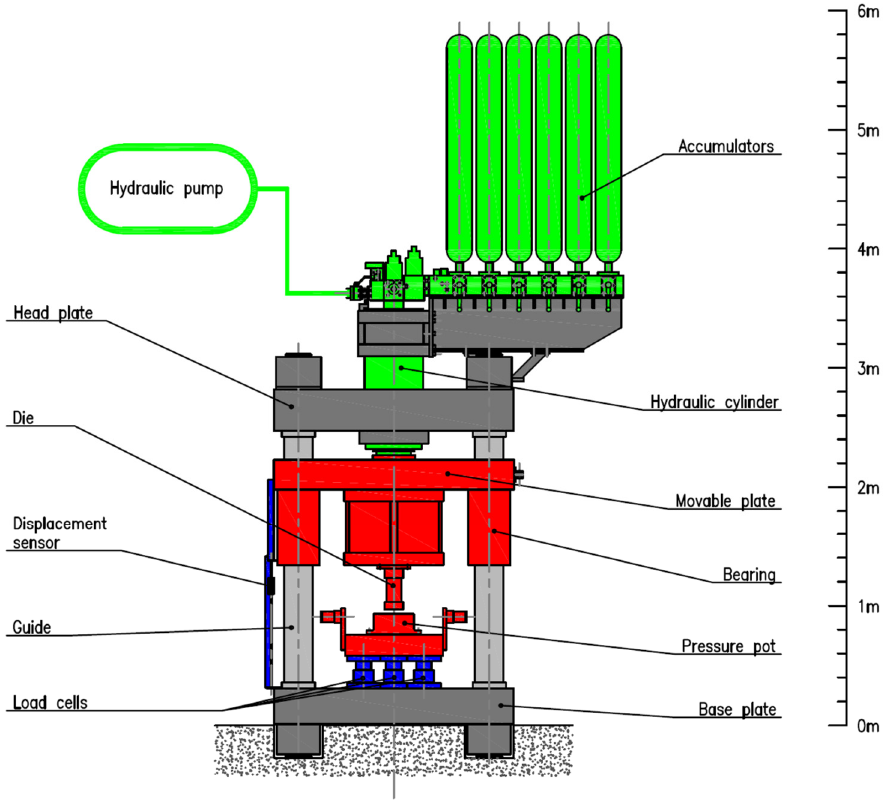
Figure 4. Piston–die test rig (schematic) [27]. Table 2. Experimental The piston–die tests were conducted on a 4-column hydraulic press, type KV 135.02 (Rucks Maschinenbau GmbH, Glauchau, Germany). The main experimental parameters